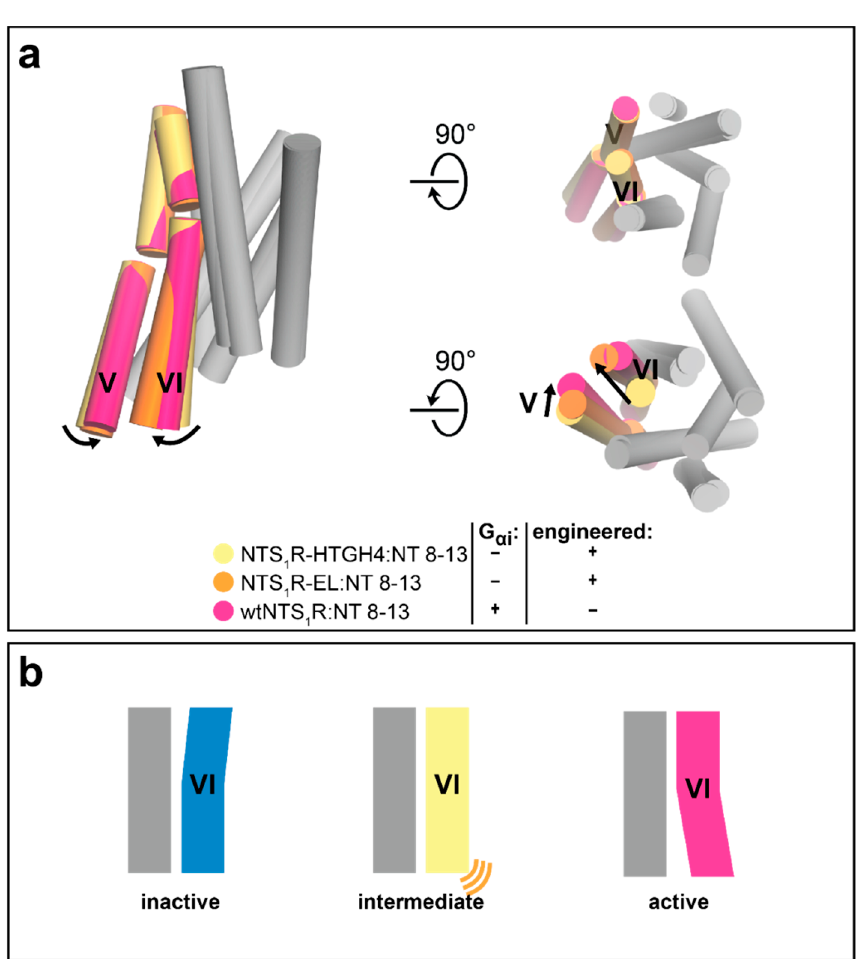
Figure 5. Engineered receptors are stabilized in biologically relevant states. Conformational changes during class A receptor activation. ( a ) Superposition of NTS 1 R-HTGH4 (PDB ID: 4BWB), NTS 1 R-EL (PDB ID: 5T04), and wtNTS 1 R:G α i (PDB ID: 6OS9), all in complex with NT 8–13. Transmembrane helices V and VI are highlighted in color. Conformational changes are indicated by black arrows. ( b ) Schematic overview of receptor conformational states. From left: inactive conformation with ex- panded extracellular binding pocket and contracted intracellular helix bundle (blue, none of the structures above correspond to this state). Intermediate conformation with extracellular active-like con- tracted binding site, but only loosely expanded intracellular bundle (yellow helix VI, corresponding to the yellow and orange structures above). The mobility of the cytoplasmic side is indicated by orange lines. Fully active state , indicated by contracted binding pocket and outward movement of intracellular helix ends of helices V and VI